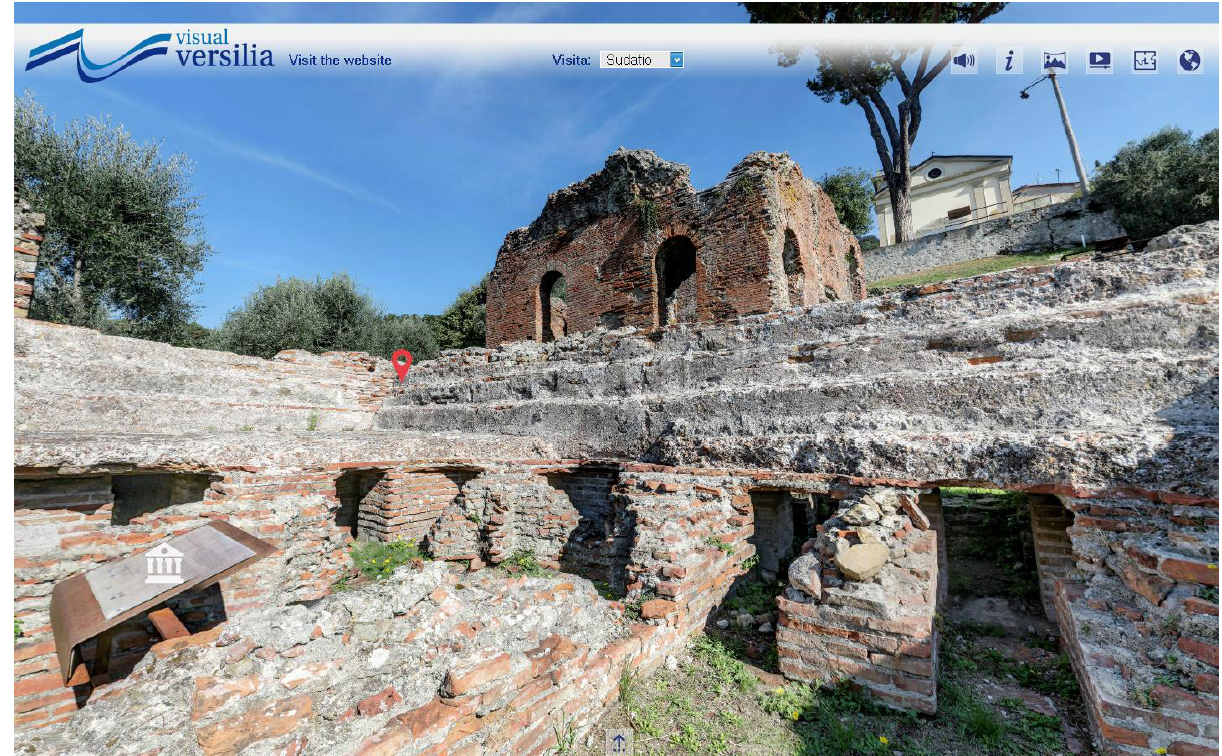
Figure 5. Web view of the virtual tour, sudatio (Z in Figure 2) - thermal area of Massaciuccoli archaeological site: the tourist can interactively navigate through the various rooms and immerse within the current appearance of the site. Red hotspots identifies next point of interest and other symbols (the white temple) highlights link to supplementary